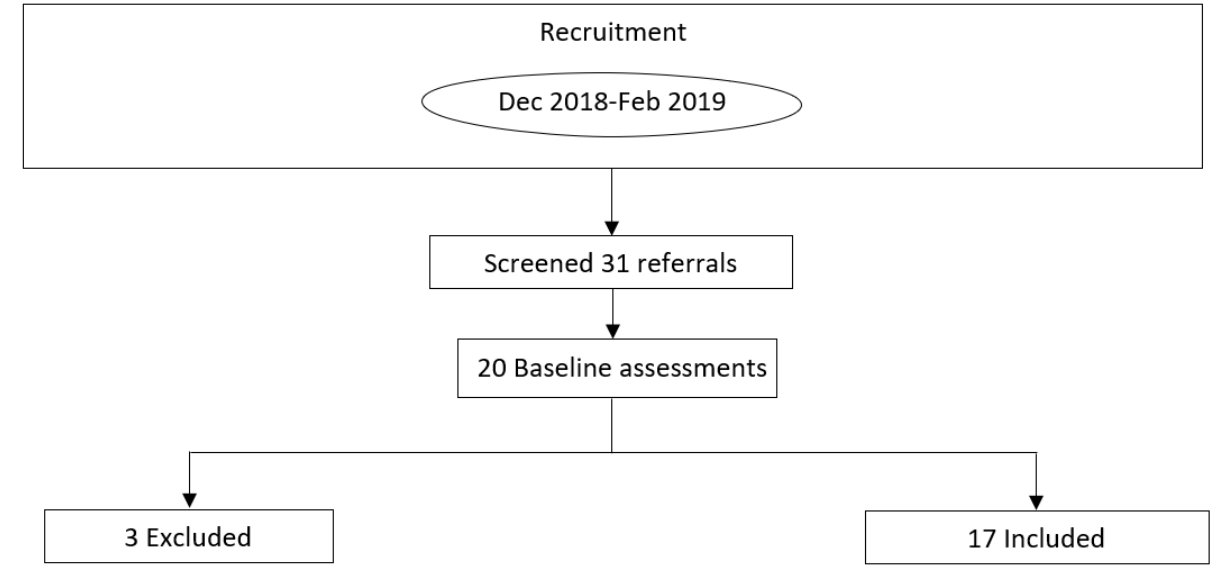
Figure 1. Schematic representation of study